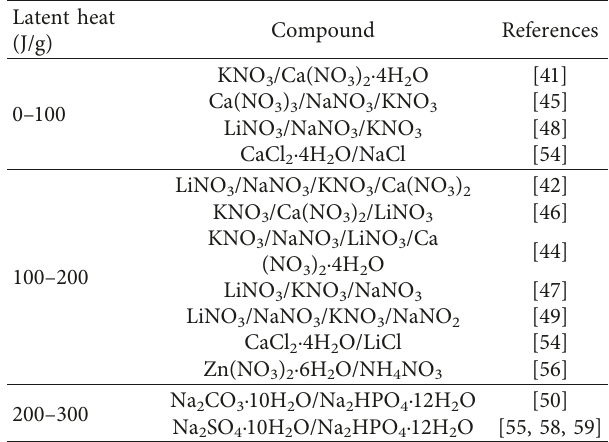
Table 2: The latent heat of low-temperature inorganic eutectic